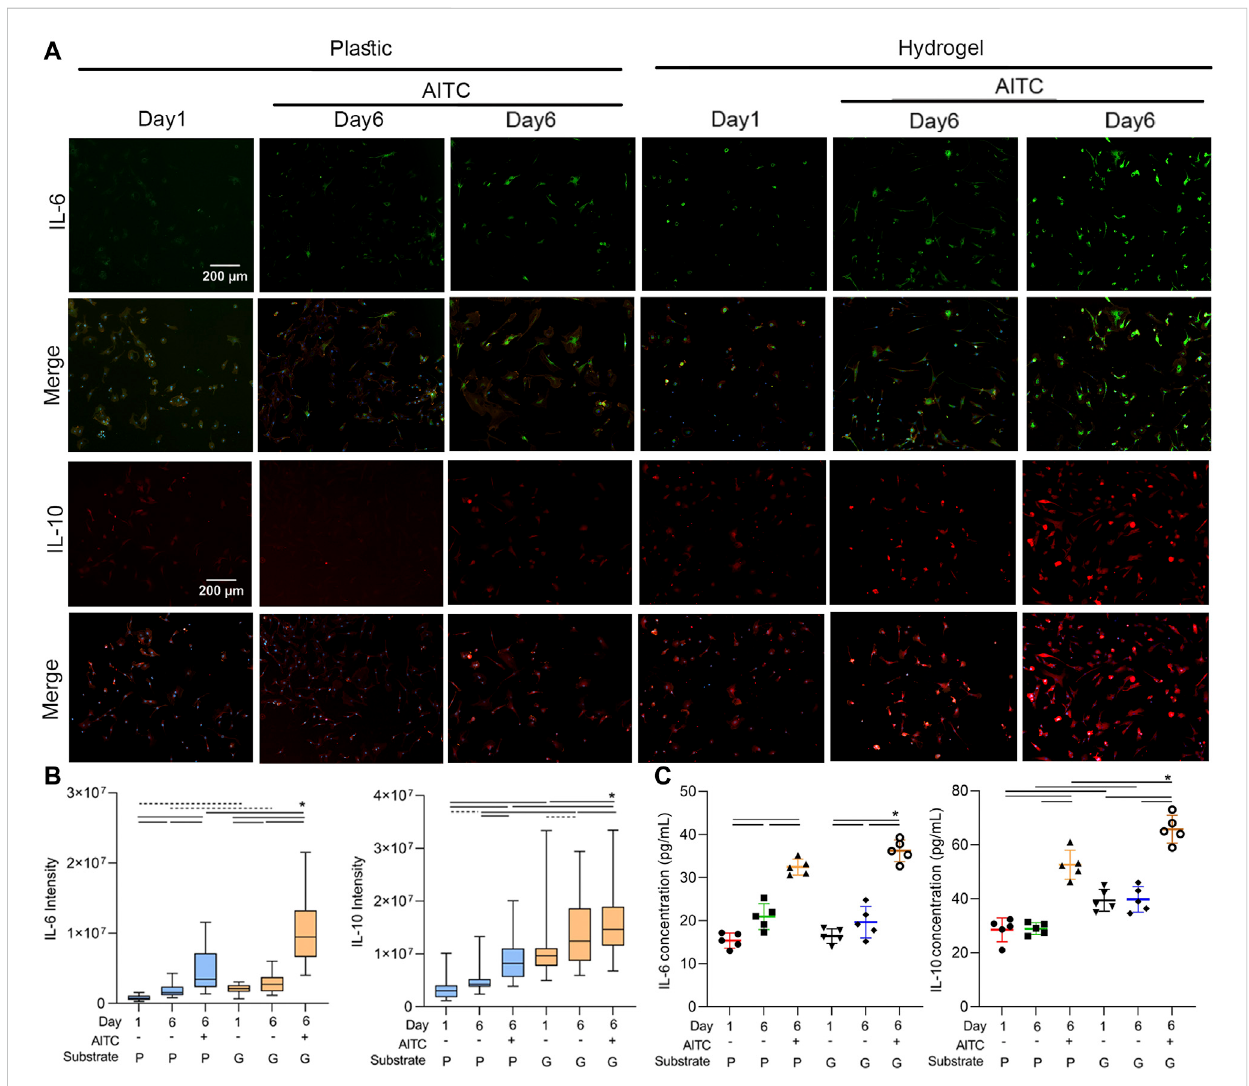
TRPA1 activation regulated the in fl ammation of CHs. CHs were divided into two groups: one was cultured on plastic and the other was cultured on hydrogel.Eachgroupwasthensub-groupedintothree:1-dayculture,6-dayculture,and6-dayculturewithAITCtreatment. (A) Representativeimagesof IL-6 or IL-10 and mergedwith F-actin and nucleus staining of CHs, and thequantitative analysis of (B) IL-6 and IL-10 intensity; (C) ELISA measurementof cellularIL-6and IL-10levels.Resultsareexpressedusingtheboxplots ( n =80 – 200cellsintheIFmeasurement, n =5samplesintheELISAanalysis). RepeatedmeasuresANOVAfollowedbyDunnett ’ spost-testwasused inthestatistical analysis,and a t -testwasalsoappliedwhenthedifference wasnot signi fi cant with the ANOVA test. The differences are considered statistically signi fi cant at p < 0.05. (P: plastic, G: hydrogel; line: line on the top of the box points to the compared objects with ANOVA, dot line: test with t